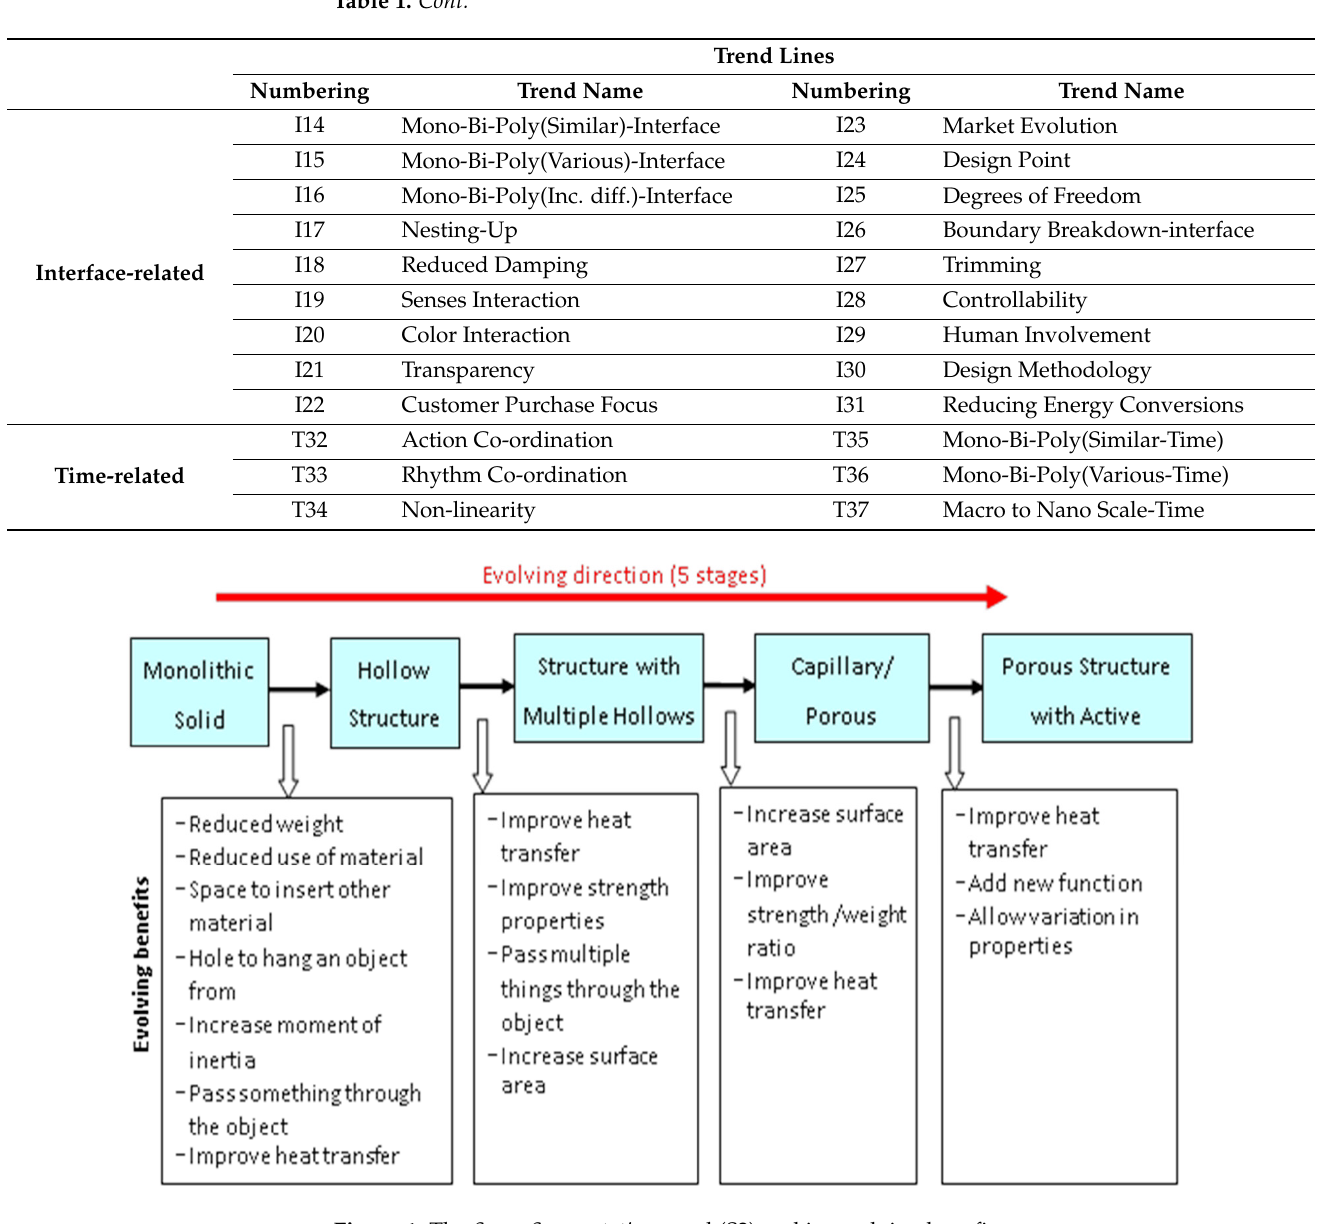
Figure 1. The Space Segmentation trend (S2) and its evolving benefits.